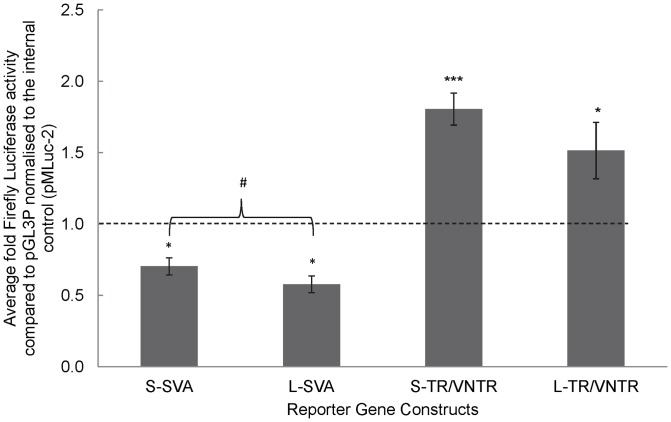
The SVA and the VNTR within show distinct functional properties in a reporter gene construct.Reporter gene constructs containing each allele of the FUS SVA and TR/VNTR (long and short) were transfected into the neuroblastoma cell line, SK-N-AS. The fold values of activity demonstrated by each construct compared to pGL3P normalised to the internal control (pMLuc-2) to account for differences in transfection efficiency are displayed. Both alleles when tested as a complete SVA showed repressive function and were significantly different to each other. When the alleles were tested as a smaller fragment consisting of the central TR/VNTR region they both showed enhancer properties. One tailed t-test was used to measure the significance of fold activity of the FUS SVA and TR/VNTR over the minimal promoter of the pGL3P vector *P<0.05, ***P<0.001, and to compare the activity of the alleles of the SVA and the TR/VNTR to each other # P<0.05.